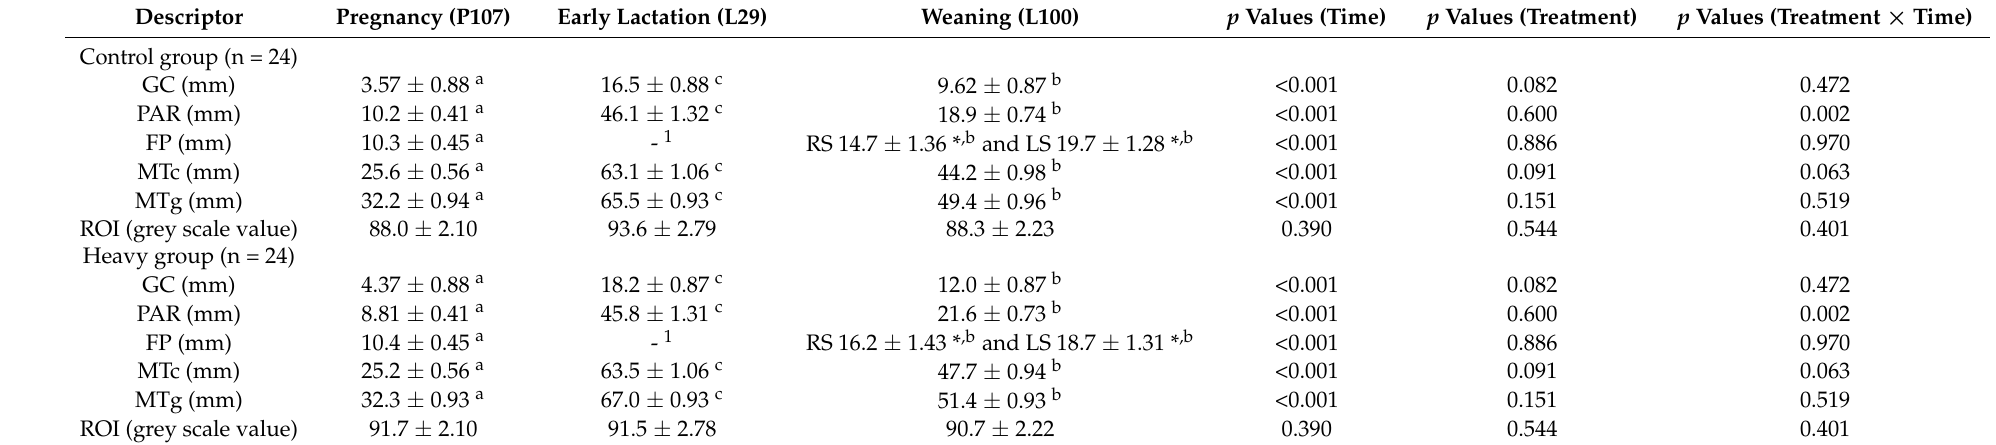
Table 3. Effect of time (P107, L29, L100) and treatments (control vs. heavy) on depths of the mammary gland cistern (GC), parenchyma (PAR), fat pad (FP), the total mammary depth conservative and generous (MTc and MTg), and the grey-scale value of regions of interest (ROI) in the parenchyma (least-square means ± SEM).